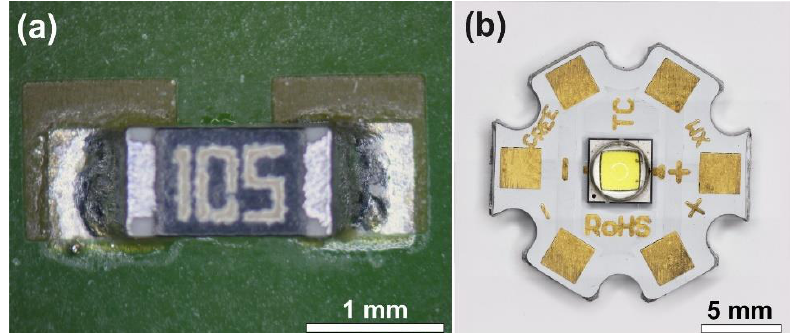
Figure 1. The samples tested: ( a ) soldered 0630 chip resistors; ( b ) the XMLBWT-02-0000-000HT20E7 power LED and the alumina substrate (Hirox optical microscope).